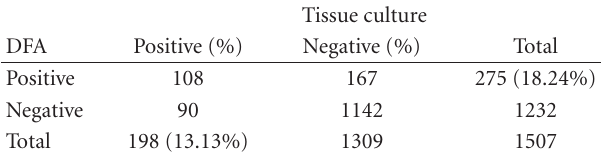
Table 2: Comparison of DFA with tissue culture isolation. Tissue culture